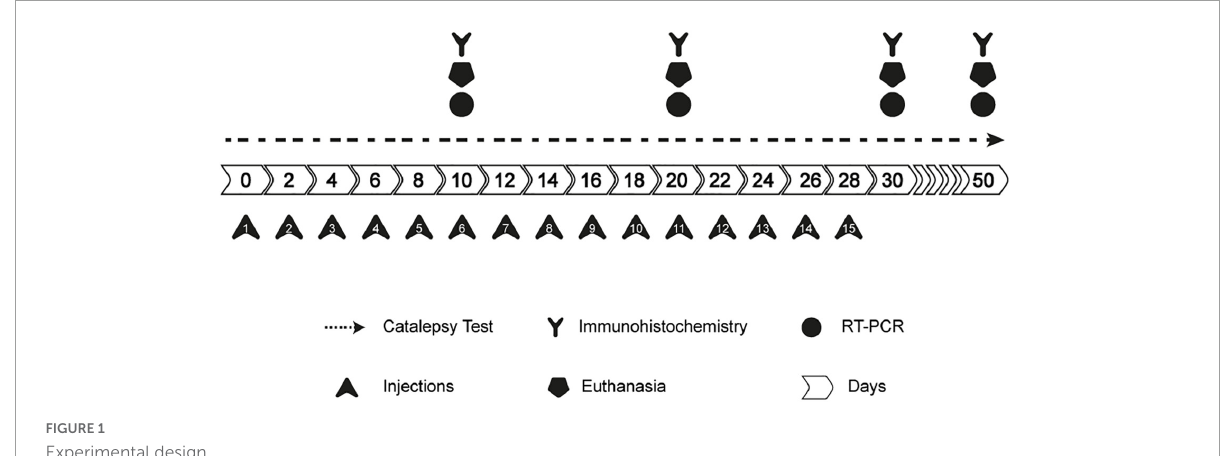
FIGURE1 Experimental